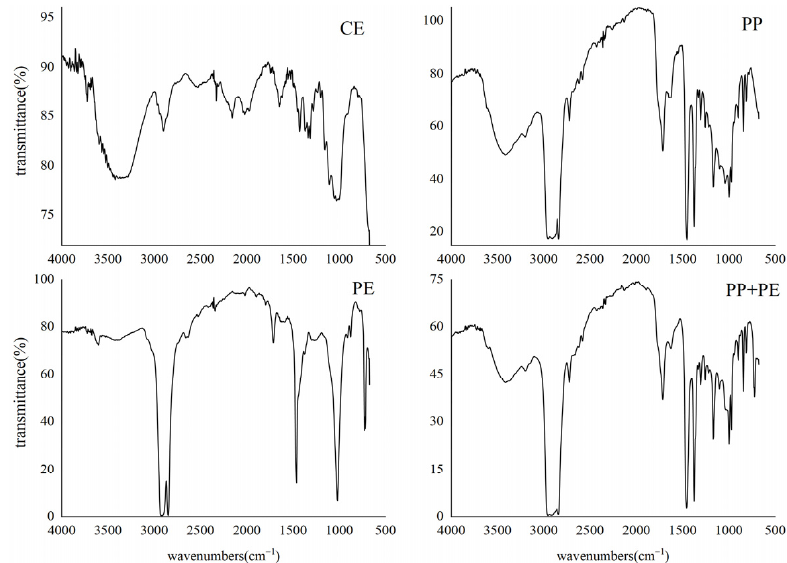
Figure 6. Infrared spectroscopy of typical microplastics in the Lincheng River.